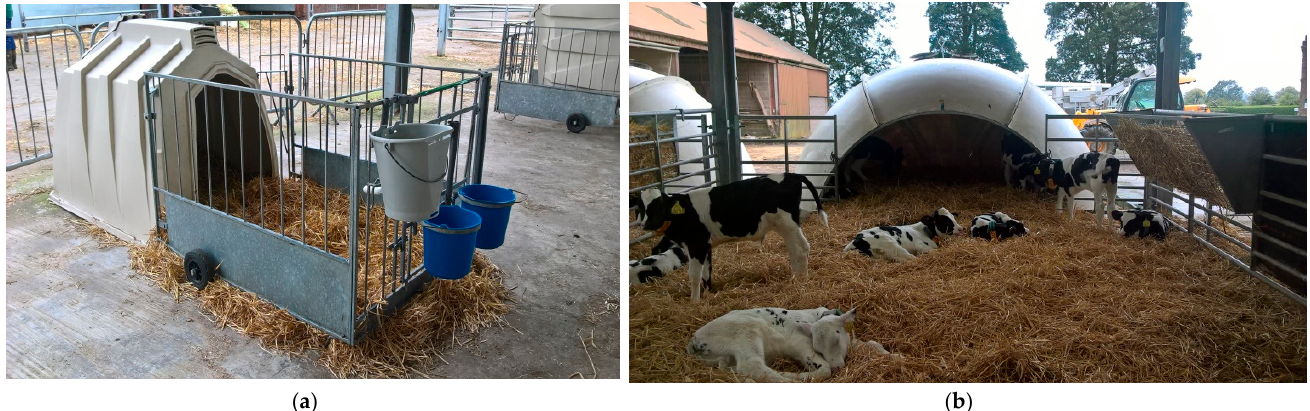
Figure 1. ( a ) Example of the individual calf hutches used in the study; ( b ) example of the group housing igloo pens used in the study.